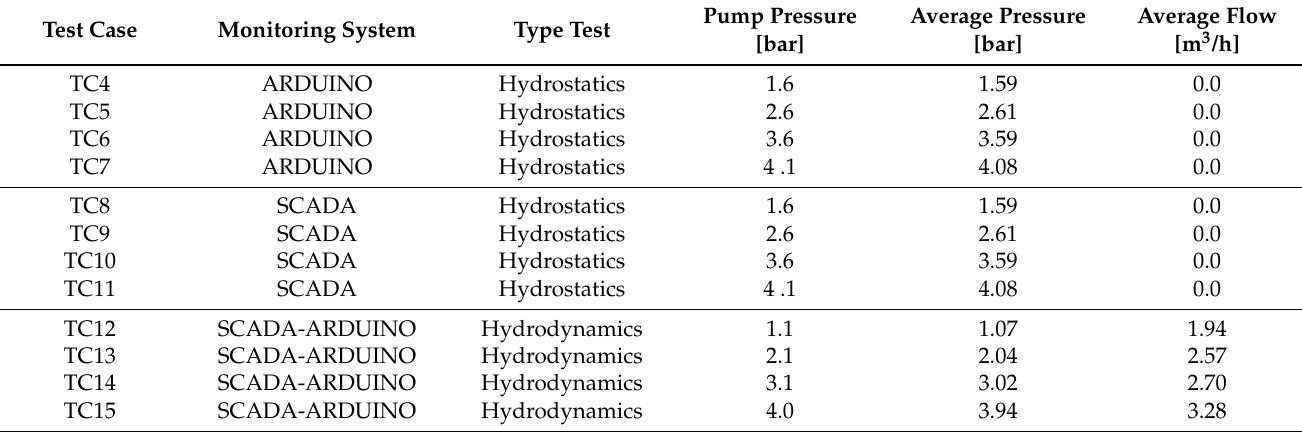
Table 2. Experimental campaign of pressure and flow rate measurements performed with Arduino. Test Case Monitoring System Type